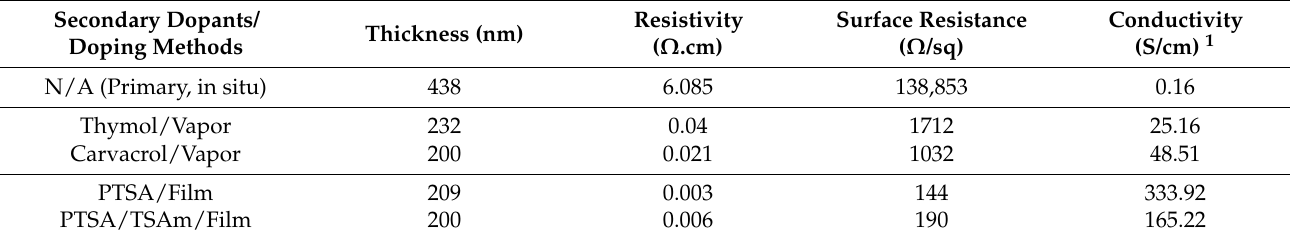
Table 1. Electrical Conductivity of Chemically Doped Polyaniline